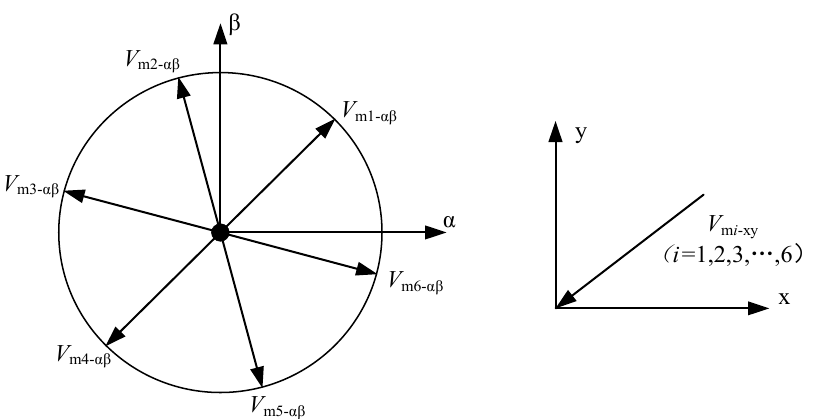
Figure 6. Distributions of the virtual vectors considering the common-mode voltage suppression on different subplace.